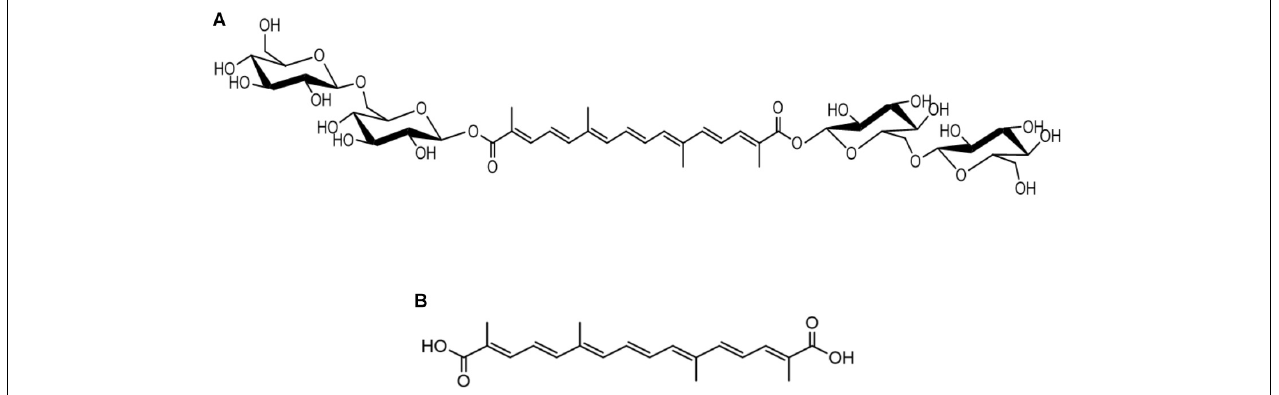
FIGURE 1 | Chemical structures of crocin (A) and crocetin (B)